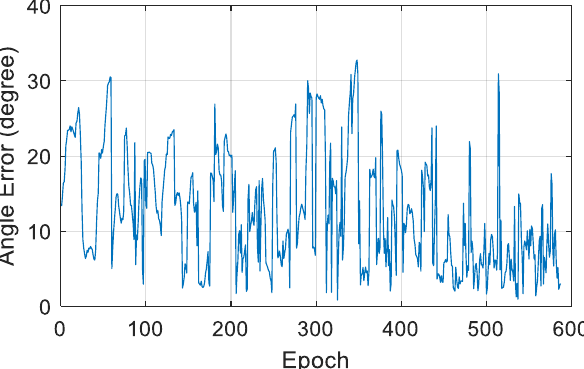
Figure 8. Angle error between two sun-pointing vectors.